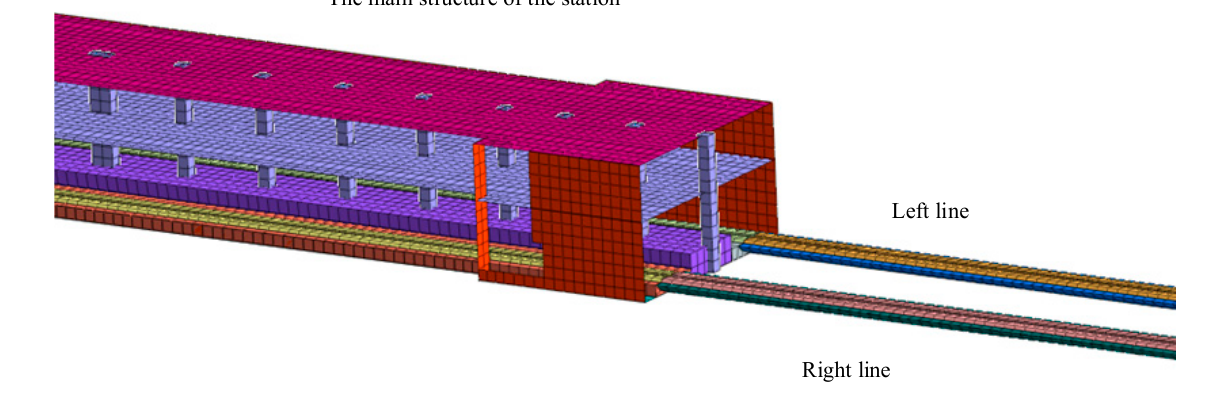
Table 5. Finite element model to simulate soil